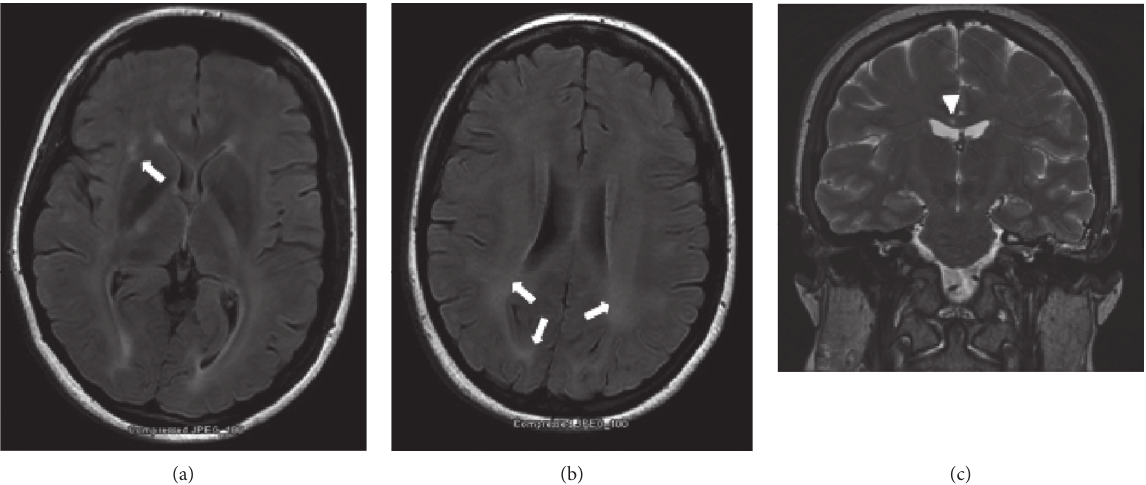
Figure 1: (a) and (b) Axial MRI brain without contrast demonstrating patchy and confluent FLAIR hyperintensity throughout the white matter, markedly abnormal for age (arrows). (c) Coronal MRI brain FLAIR sequence demonstrating a lesion in the corpus callosum (arrowhead), performed prior to her presentation to our facility.